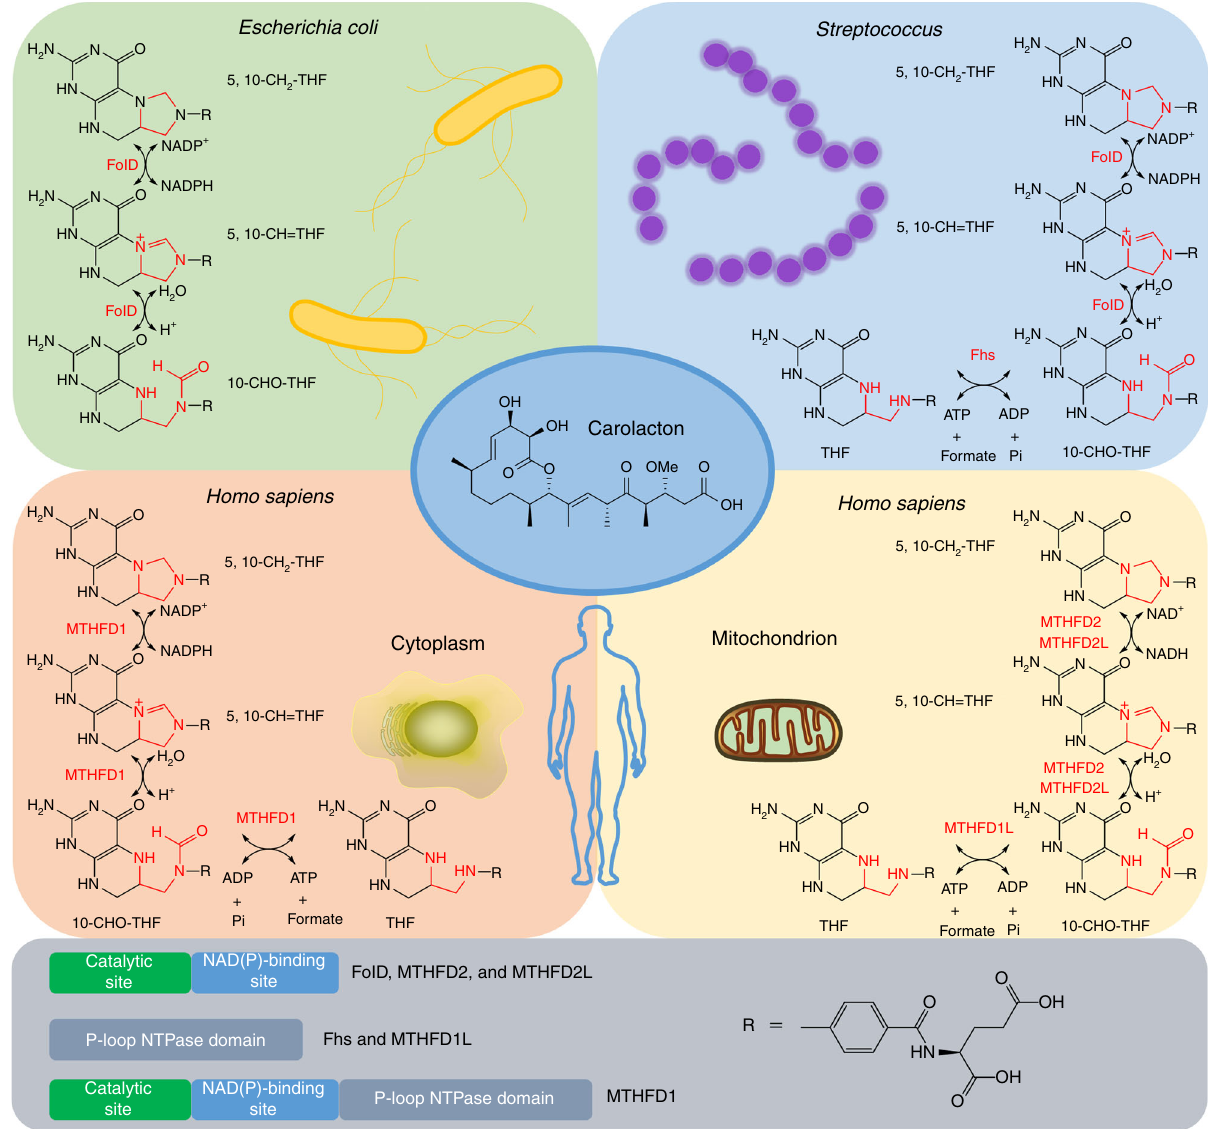
Fig. 1 The enzymatic routes to synthesize 10-CHO-THF in different organisms. In E. coli , 10-CHO-THF is synthesized by FolD, while in several other bacteria such as Streptococci, 10-CHO-THF can be produced via an alternative enzyme named Fhs. In humans, there are different enzymes in the cytoplasm and the mitochondrion. In the cytoplasm, MTHFD1, which is a tri-functional enzyme, exerts FolD-DH, FolD-CYH and Fhs functions. In the mitochondrion, while MTHFD2 and MTHFD2L have FolD functions, MTHFD1L plays the same role as Fhs. The chemical structure of FolD inhibitor carolacton is shown in the